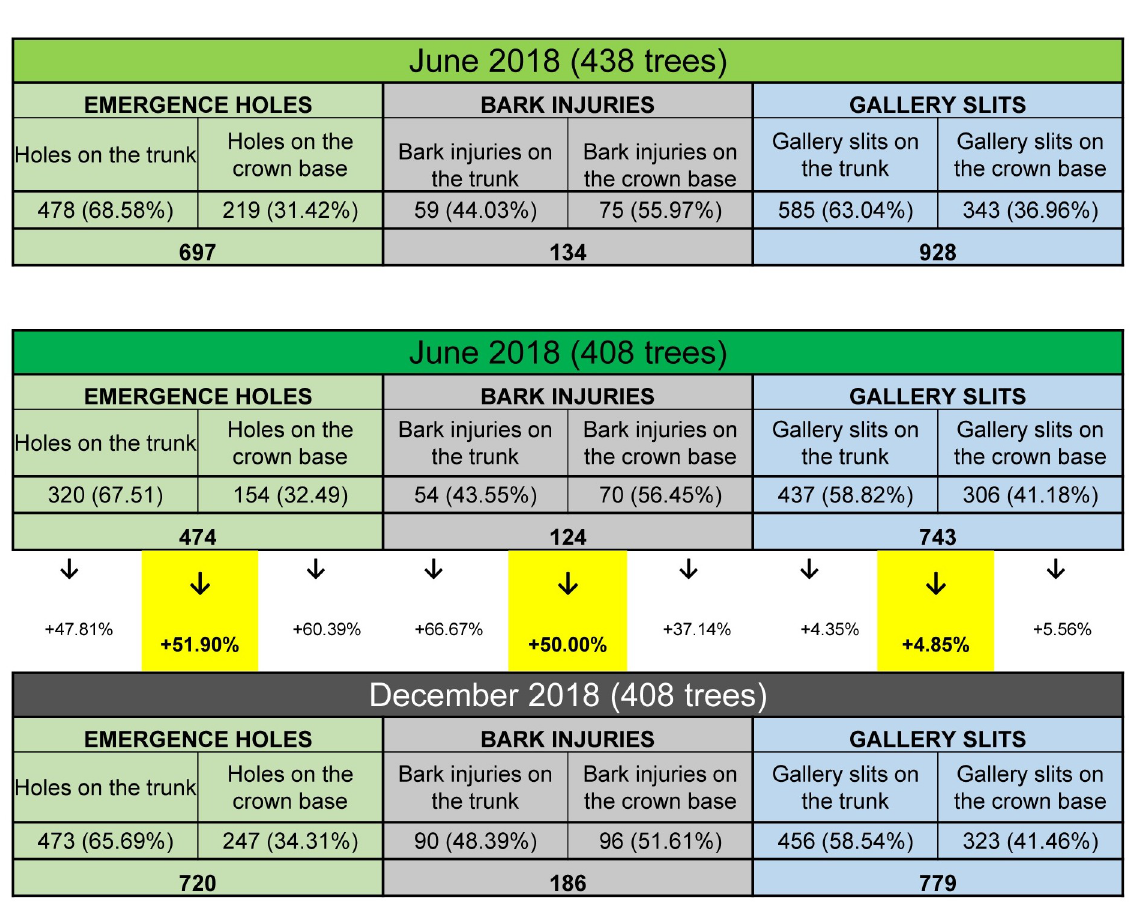
Fig 8. Summary counts for the three established infestation indicators, comparing the June and December 2018 surveys. For June 2018 figures include the 438 trees initially checked, as well as, again, for only the same 408 trees also present in December 2018, this for comparative reasons (see